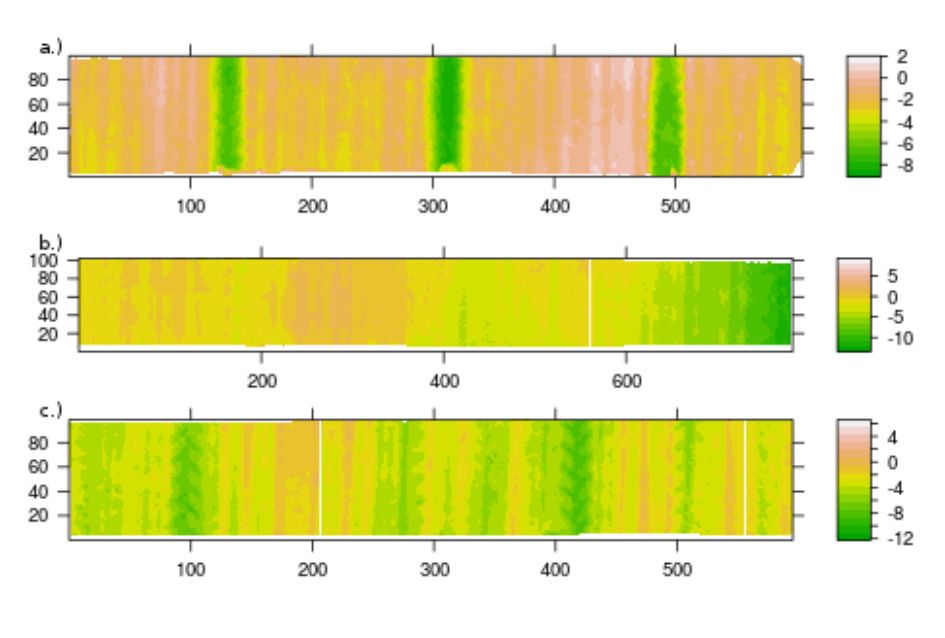
Figure 4. Three sample DSMs of different roughness plots showing ( a ) a significant two scale roughness pattern (R12), ( b ) a spatial trend (R14) and ( c ) no spatial trend with an insignificant two scale roughness pattern (R21). Units are in cm.